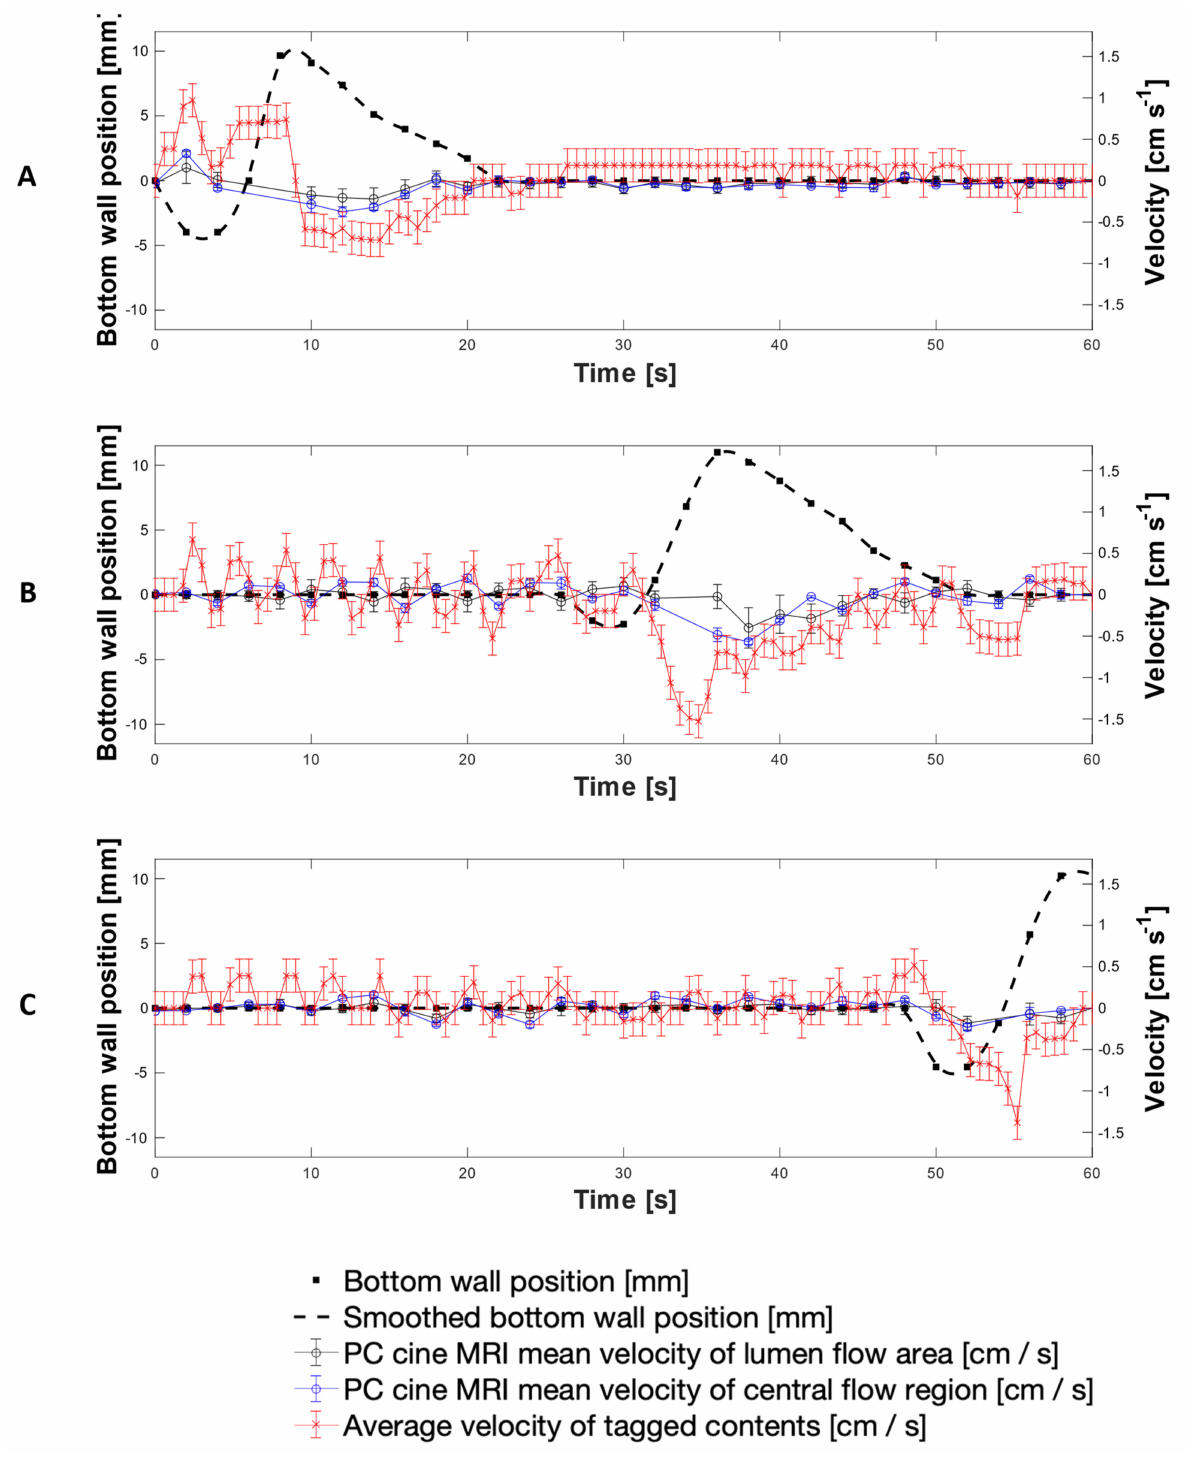
Figure 8. Average and mean velocities measured using tagged and PC cine-MRI at the location of tags 3 ( A ), 12 ( B ) and 19 ( C ), alongside wall displacement at the corresponding location (dashed